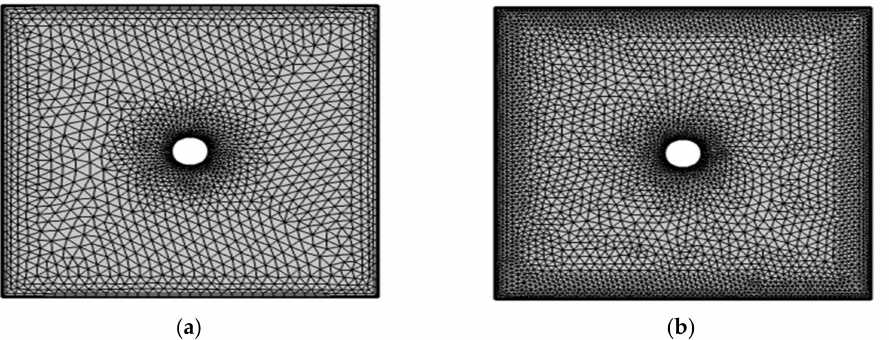
Figure 2. ( a ) meshing at fine level and ( b ) meshing at finer